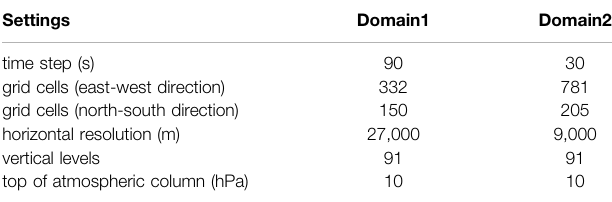
TABLE 2 | WRF domain settings applied in the parameterization experiments.